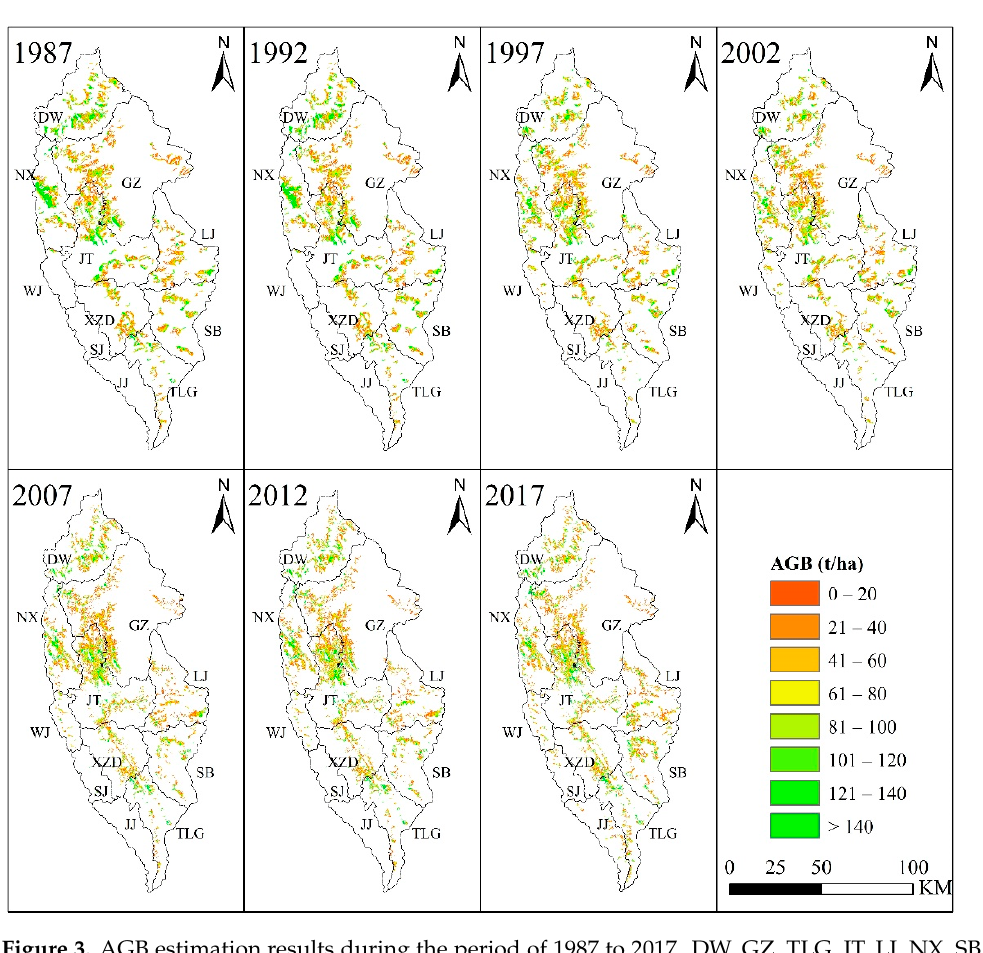
Figure 3. AGB estimation results during the period of 1987 to 2017. DW, GZ, TLG, JT, LJ, NX, SB, XZD, WJ, JJ, SJ are short for Dongwang, Geza, Tiger Leaping Gorge, Jiantang, Luoji, Nixi, Sanba, Xiao Zhongdian, Wujing, Jinjiang, Shangjiang, respectively.